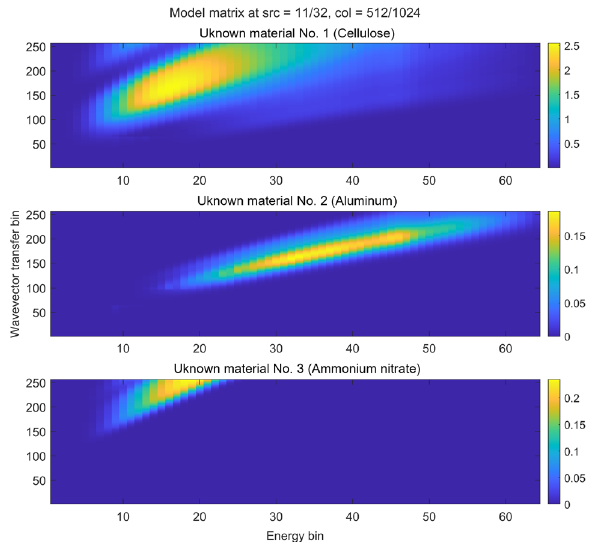
Figure 11. Showing one 3D cross-section of the full 5D matrix A . Notice that these coefficients also depend on the remaining two dimensions, i.e., the source-detector pair (only a single pair is shown here). In particular, there are more non-zero weights beyond 30 keV for the unknown material No. 3 at other pairs, all of which are used in the reconstruction. The matrix A does not depend on the nature of the materials. The identities of the three unknown materials will only be revealed after reconstruction and fingerprinting against the database of known diffraction